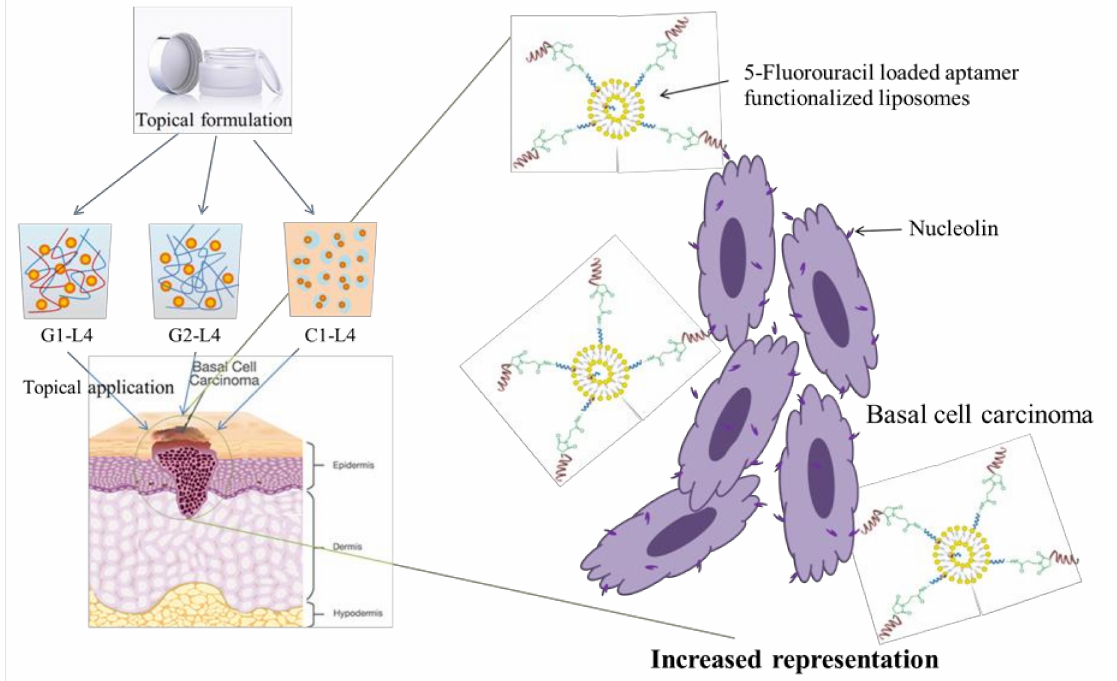
Figure 1. Schematic illustration of the mechanism of action to treat